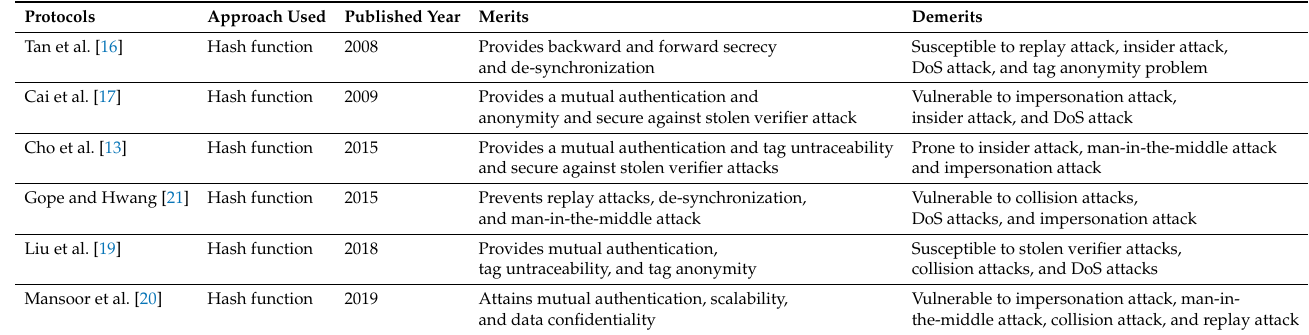
Table 2. Merits and demerits of the existing authentication protocols in RFID environments.